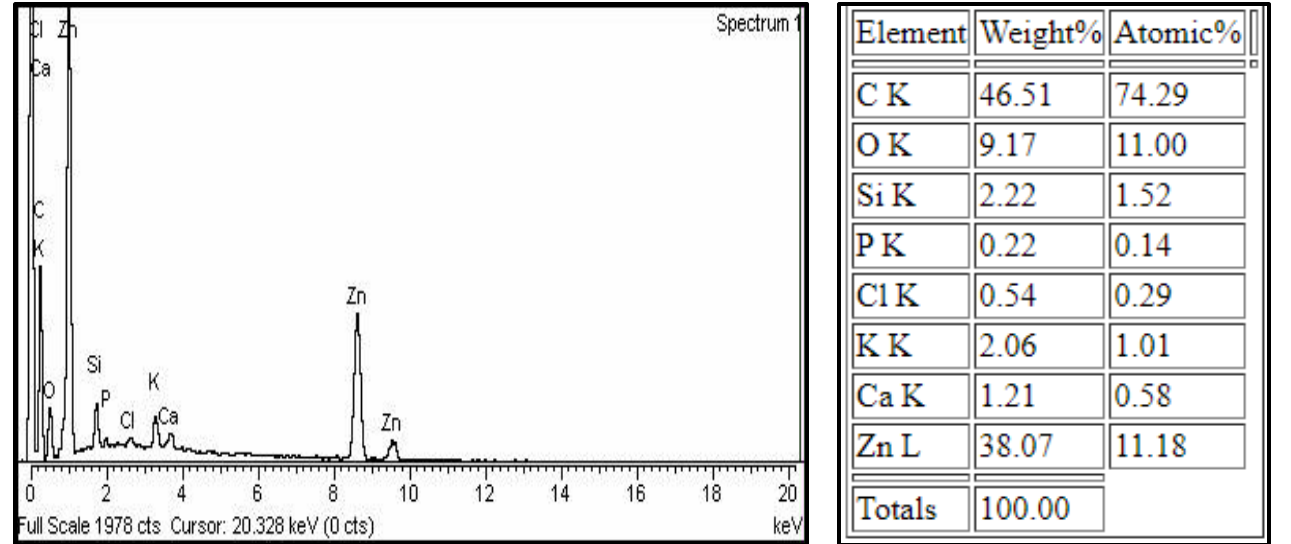
Figure 6. EDX graph ( A ) and elemental exploration of MB-ZnO nanocomposite ( B ).